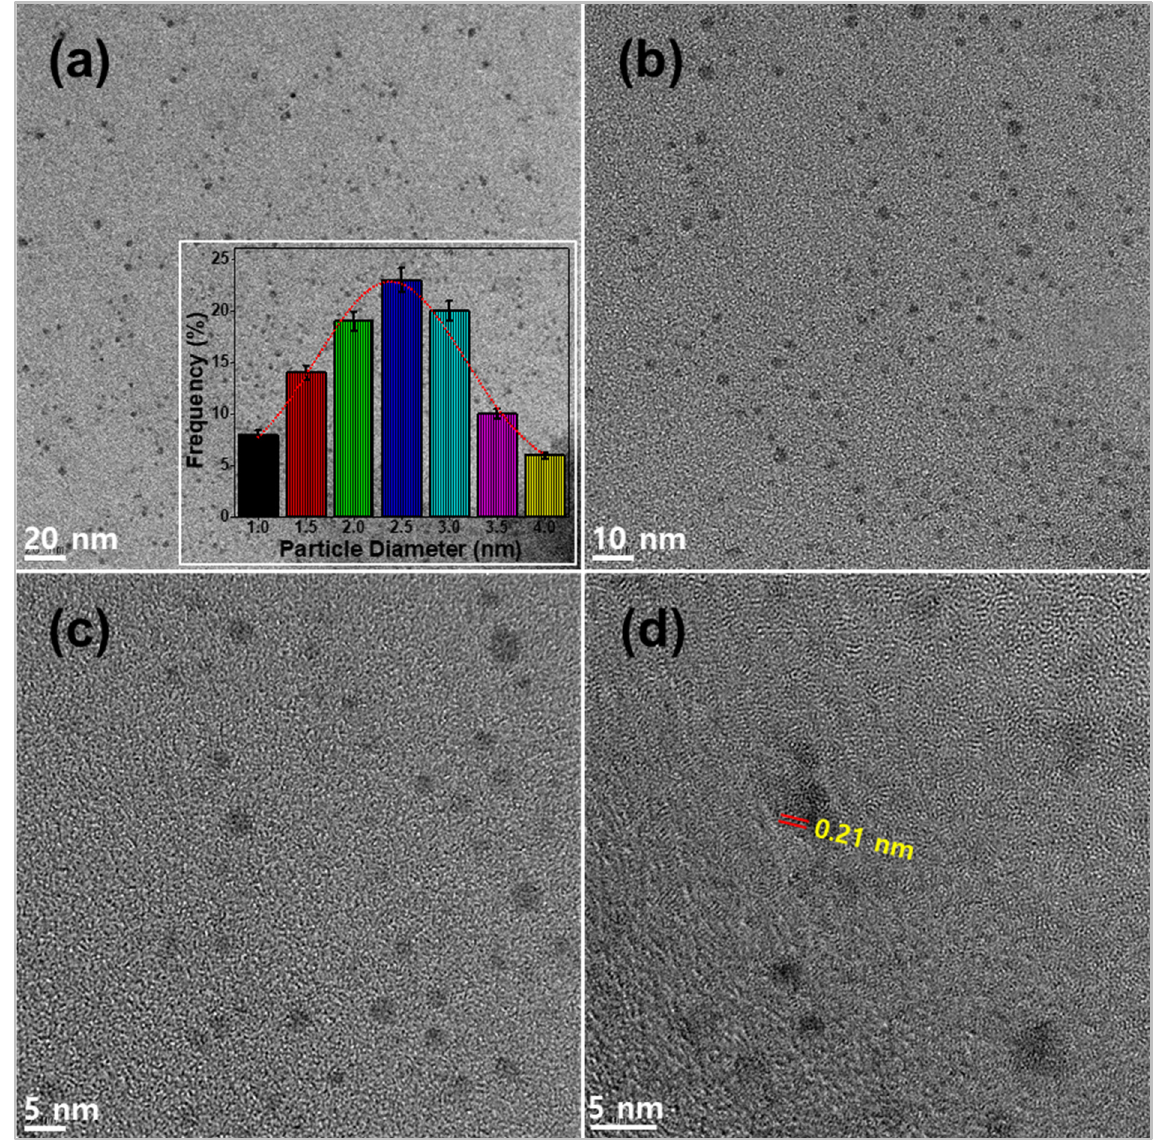
Figure 2. TEM/HRTEM images with different magnifications of prepared natural nitrogen-doped carbon dots.